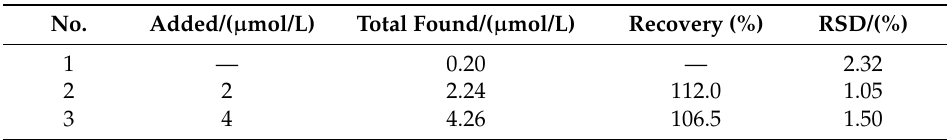
Table 3. The results of the determination of tartrazine in a soft drink at different adding concentrations ( n =